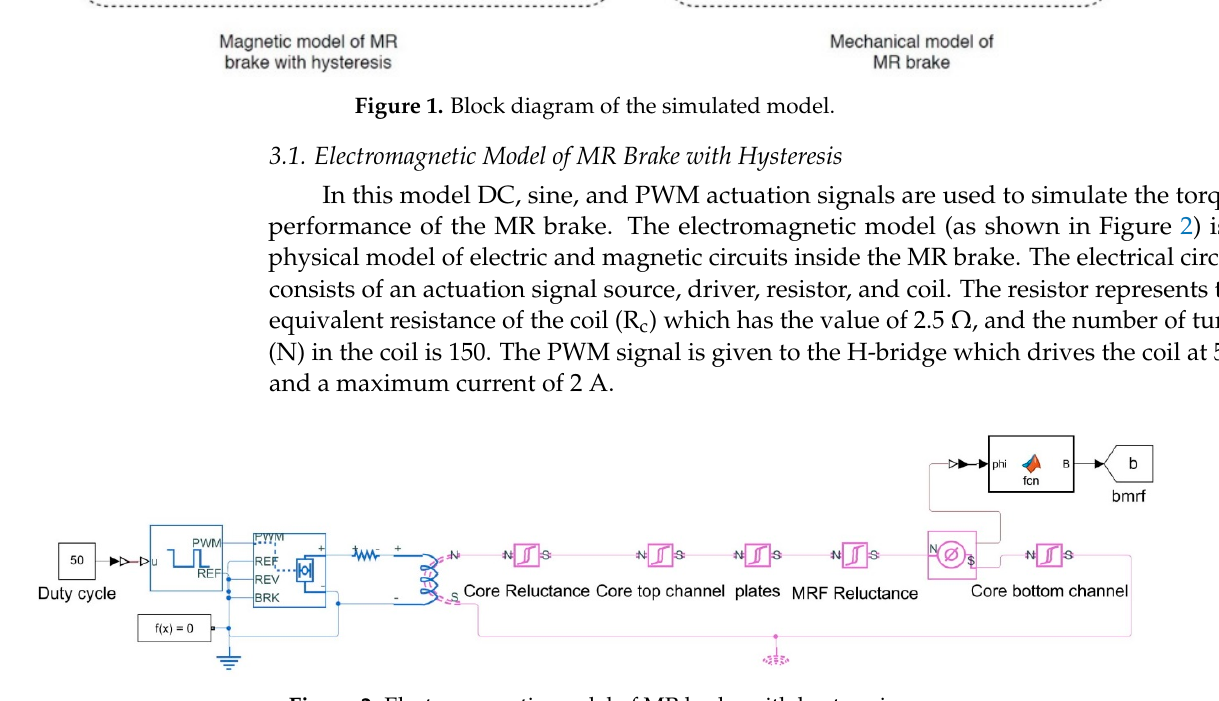
Figure 2. Electromagnetic model of MR brake with hysteresis.